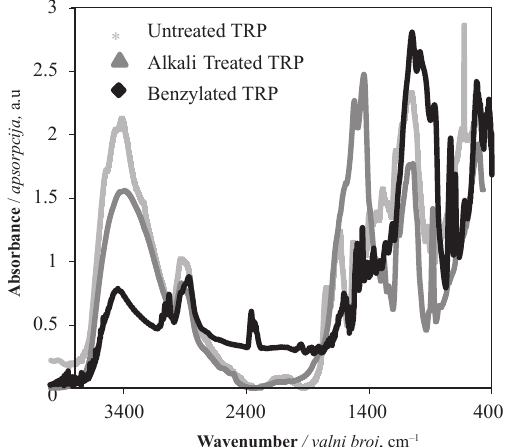
Figure 2 FTIR spectra of untreated and chemically treated TRP sawdust of Turkish red pine (TRP)